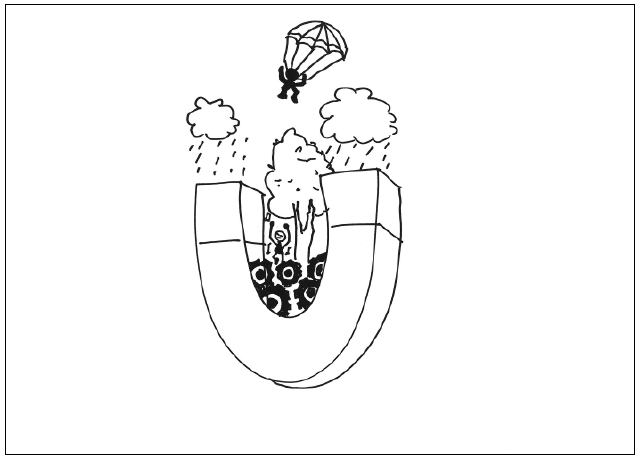
Figure 4. Work by PT4 Conscientiousness.